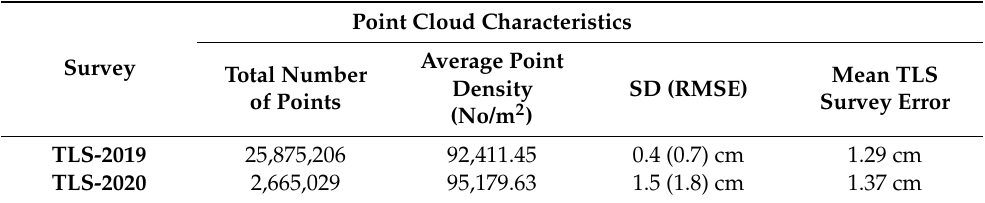
Table 4. Point cloud statistics calculated by M3C2 for performed multi-temporal TLS surveys.